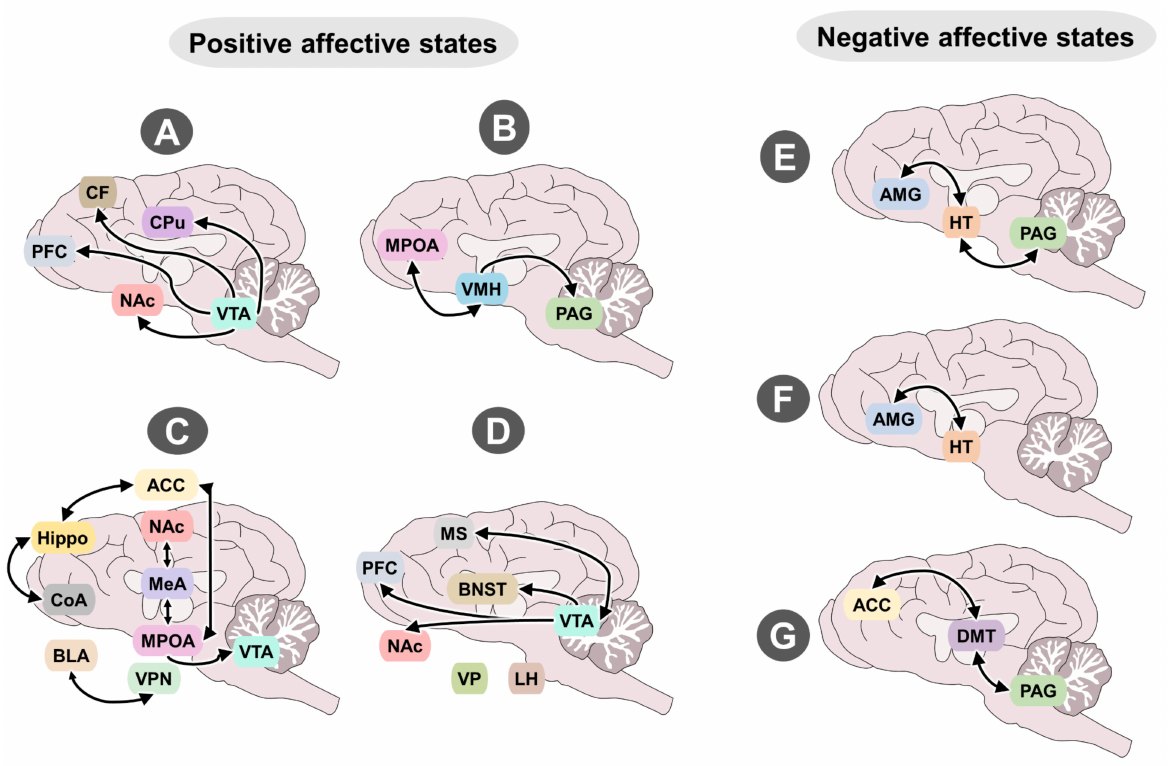
Figure 3. The seven basic behavioral neurocircuits according to Panksepp [9], schematized in a sagittal section of a dog’s brain. On the left side are the systems that evoke positive affective states: ( A ) seeking; ( B ) lust; ( C ) care and ( D ) play. On the right are the ones that evoke negative affective states: ( E ) rage; ( F ) fear; and ( G ) panic. Numerous brain regions are involved in these systems: amygdala (AMG), hypothalamus (HT), periaqueductal gray matter (PAG), anterior cingulate cortex (ACC), dorsomedial thalamus (DMT), prefrontal cortex (PFC), frontal cortex (CF), nucleus accumbens (NAc), ventral tegmental area (VTA), caudal putamen (CPU), medial preoptic area (MPOA), ventromedial hypothalamus (VMH), hippocampus (Hippo), cortical amygdala (CoA), basolateral (BLA), medial (MBA), and paraventricular nuclei (PVN), medial septum (MeA), bed nucleus of the stria terminalis (BNST), ventral pallidum (VP), and lateral hypothalamus